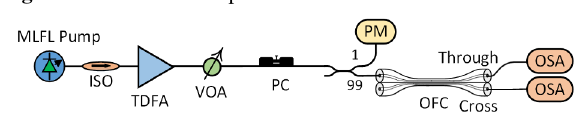
Figure 2. Transmission spectra of OFC #1.